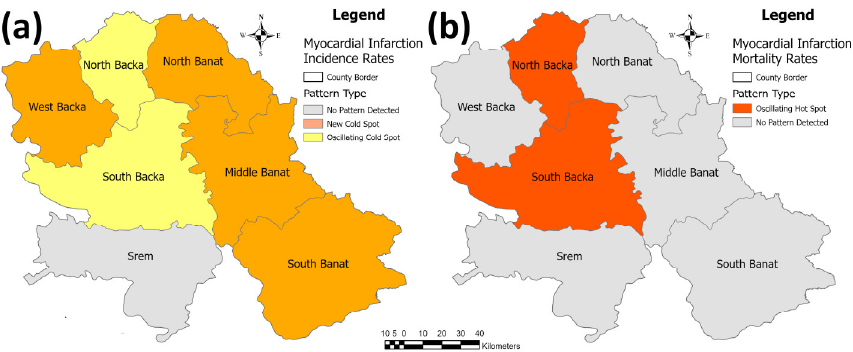
Figure 9. Identified patterns in the emerging hot spot analysis for the myocardial infarction inci- dence/mortality rates per 100,000 population in the province: ( a ) incidence rates, and ( b ) mortality